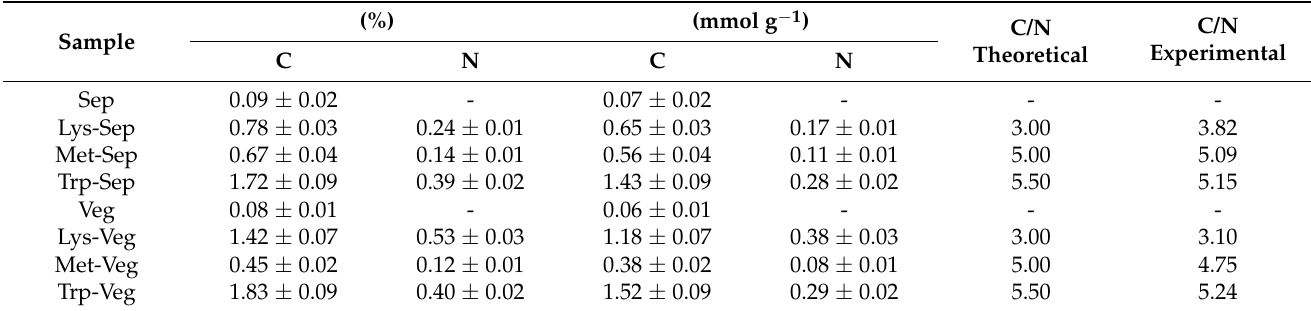
Table 4. Results obtained from elemental analysis (CHN) for the obtained samples.